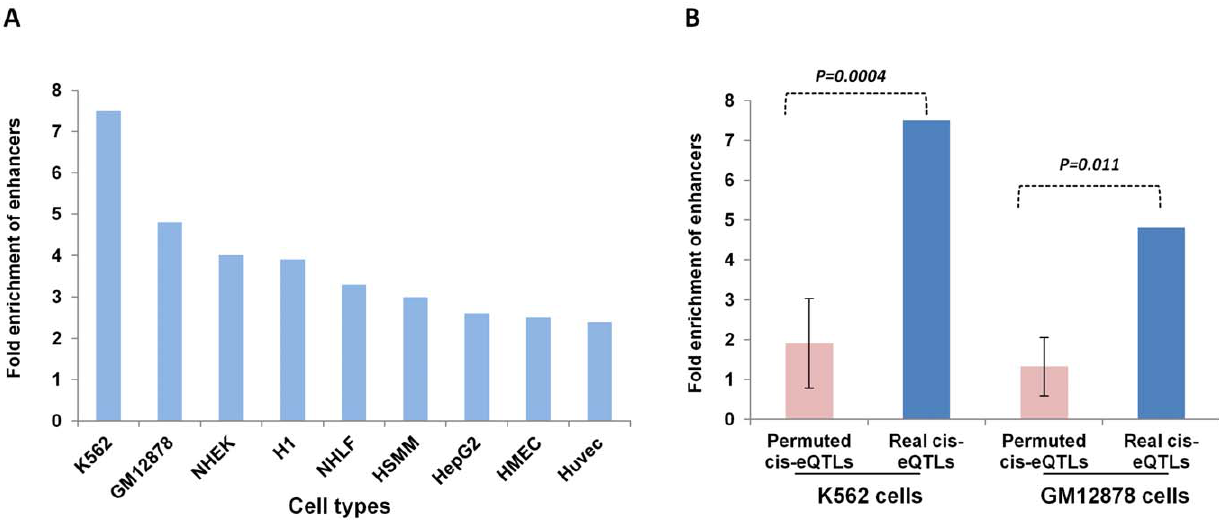
Figure 3. Localization of lincRNA cis -eQTLs in regulatory regions. (A) A plot to indicate the location of lincRNA cis -eQTLs in cell-specific enhancers. The x-axis shows the different cell lines analyzed and the y-axis shows the fold enrichment of enhancers. (B) A plot to show the difference in fold enrichment of enhancers for real lincRNA cis -eQTLs compared to permuted lincRNA cis -eQTLs. The significance of the difference in fold enrichment was tested by T-test. The HaploReg database was used to analyze the fold enrichment of enhancers.